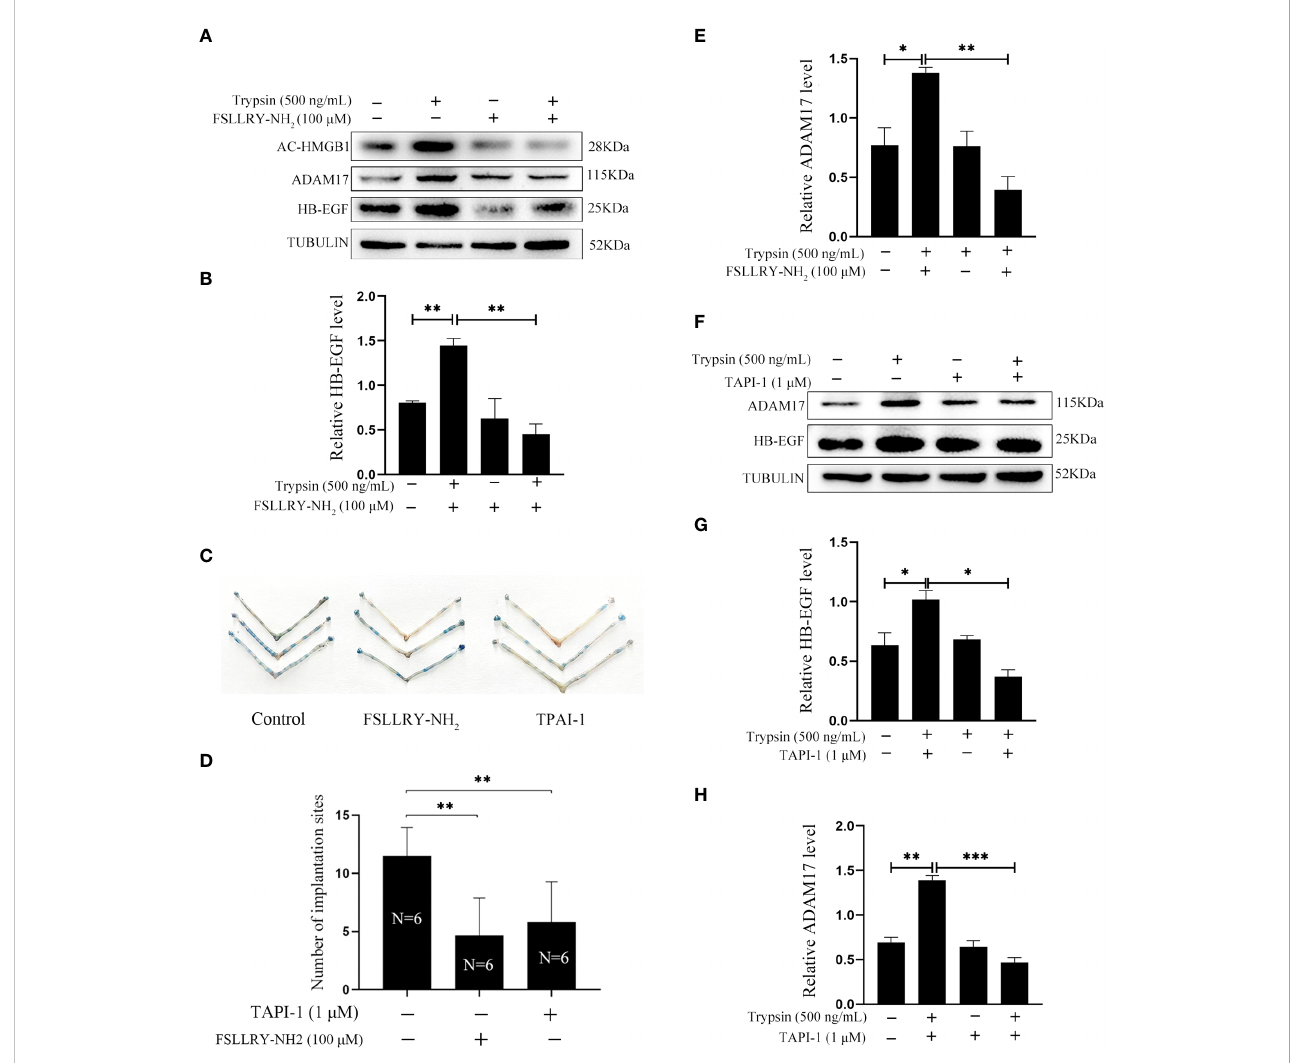
FIGURE 4 Effects of PAR2 inhibitor and ADAM17 inhibitor on the protein levels of acetylated HMGB1, ADAM17 and HB-EGF in cultured mouse epithelial cells. (A) Western blot analysis on the protein levels of acetylated HMGB1, ADAM17 and HB-EGF after mouse epithelial cells were pretreated with FSLLRY-NH m M, PAR2 inhibitor) for 24 h and further treated with trypsin for 15 min in the absence or presence of FSLLRY-NH (C) The morphology of mouse uteri on day 5 of pregnancy after day 4 pregnant mice were intraluminally injected with 3 m l of saline, 100 m M of FSLLRY-NH in saline or 1 m M TAPI-1 in saline at 09:00. (D) The number of implantation sites (blue bands) on day 5 of pregnancy after 3 m l of saline, 100 m M FSLLRY-NH 2 in saline, or 1 m M TAPI-1 in saline were intraluminally injected into pregnant mice at 09:00. By injecting 0.1 ml of 1% Chicago sky blue through the tail vein, the implantation sites were counted. (E) The relative ADAM17 in Figure 4A. (F) Western blot analysis on the protein levels of ADAM17 and HB-EGF after mouse epithelial cells were pretreated with TAPI-1 (1 m M, ADAM17 inhibitor) for 30 min and further treated with trypsin for 15 min in the absence or presence of TAPI-1. (G, H) Relative quantitation on the protein levels of HB-EGF and ADAM17 in Figure 4F. *p < 0.05, **p < 0.01, ***p <